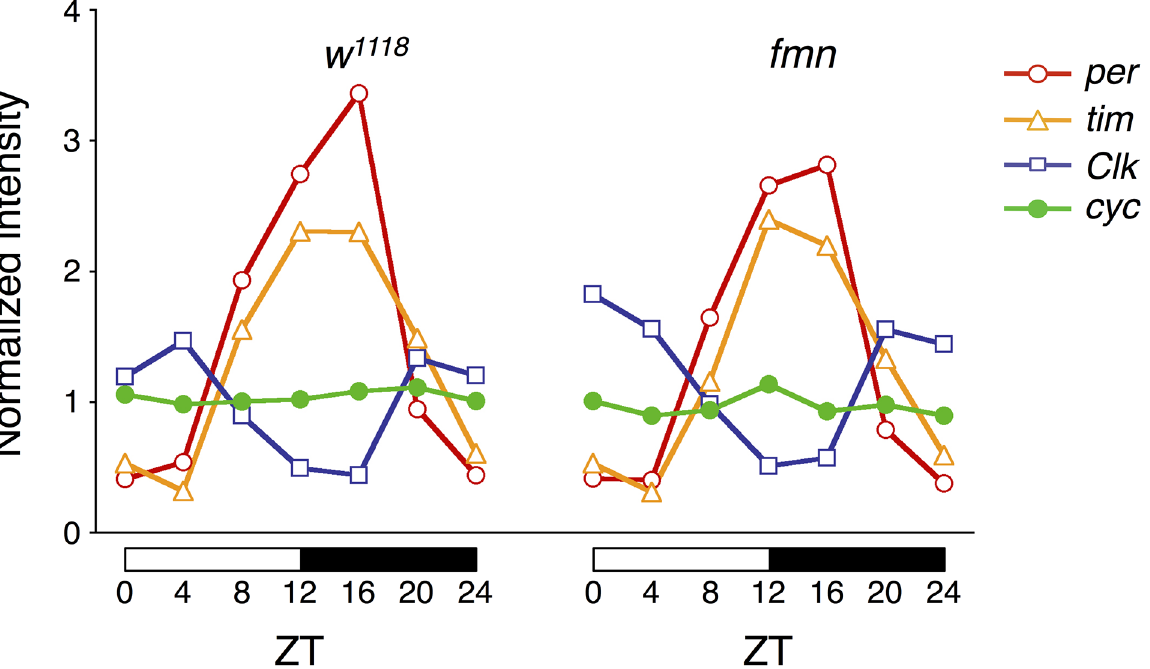
Fig 1. Clock gene cycling is not altered in fmn . Temporal expression patterns of circadian clock genes ( per , tim , Clk and cyc ) in the heads of control ( w 1118 ) and fmn flies under LD conditions. Data were normalized to the average signal intensity from each time point, which were set to 1.